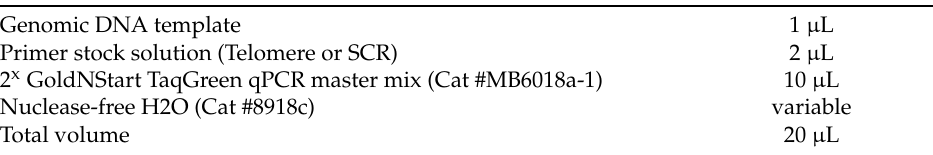
Table 3. Items used for the LightCycler ® 480 II qPCR assay.